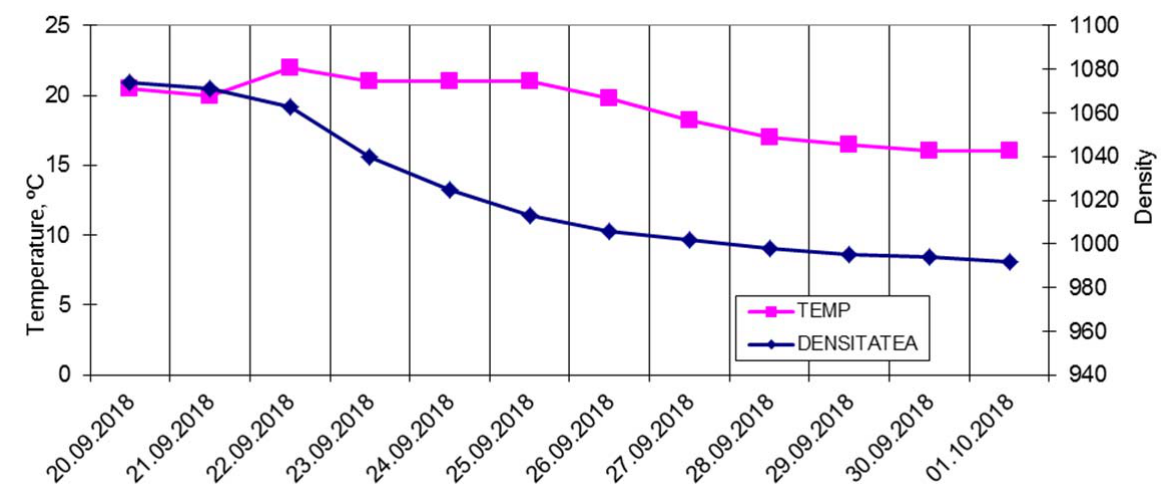
Figure 2. Dynamics of the process of alcoholic fermentation of Feteasca Regal ă must in microwinery conditions ( harvest year